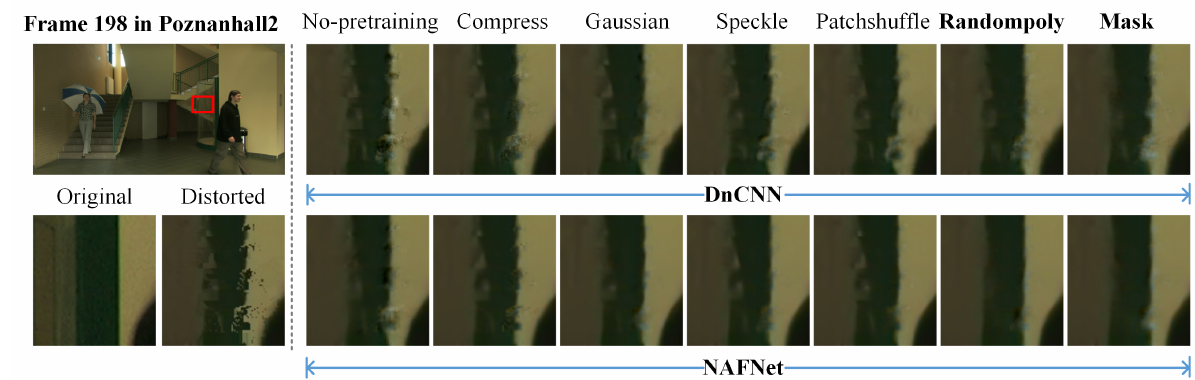
Figure 8. Visual quality comparison of two denoising models, i.e., DnCNN, NAFNet, for SVQE of Poznanhall2 with pre-training on synthetic synthesized image database with different random noise types, i.e., compress, Gaussian, speckle, patch shuffle, randompoly (proposed DIBR distortion simulation method), generated from NYU database. ‘Mask’ represents the denoising models that were further integrated with a DIBR distortion mask prediction sub-network using synthetic images generated by ‘randompoly’